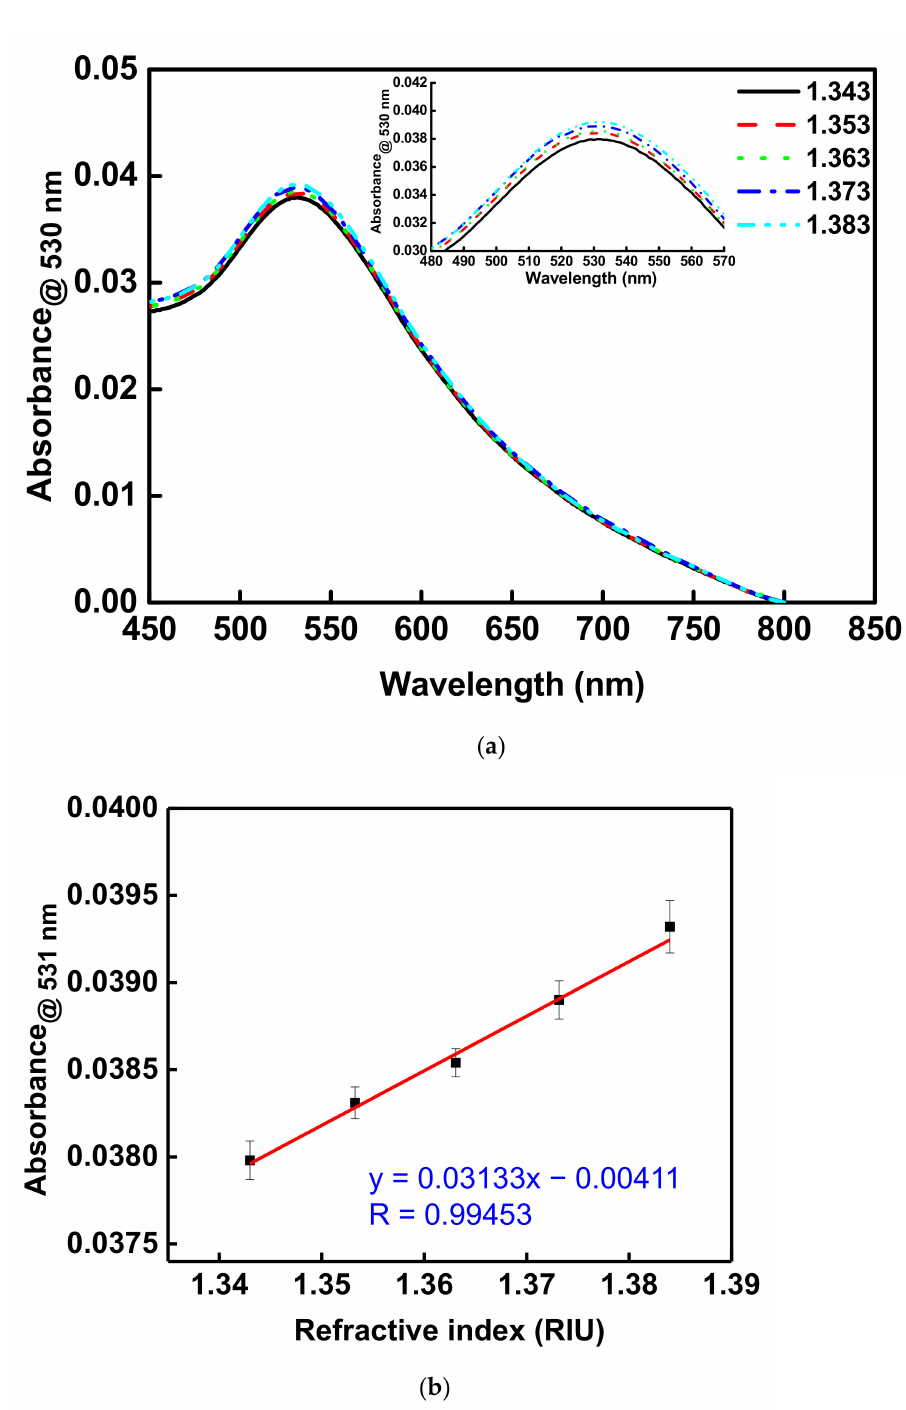
Figure 4. Optical properties of AuNPs on slide glass surface. ( a ) The RI samples at different concentrations were used for UV/Vis-NIR spectroscopy measurement. ( b ) Calibration curves of absorbance vs. refractive index for the UV/Vis-NIR